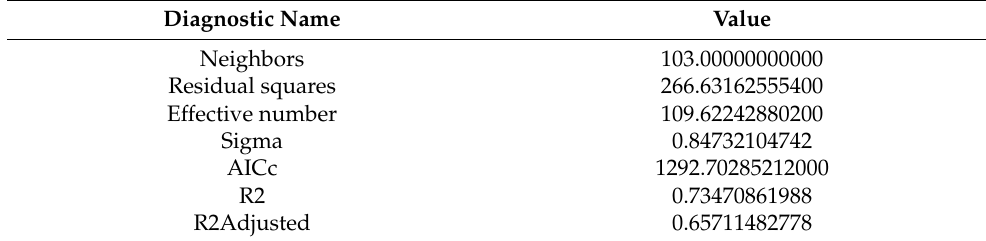
Table A4. Diagnostic information of